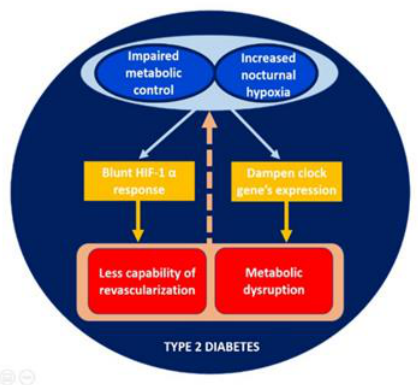
Figure 3. Proposed vicious circle in the relation between nocturnal sleep breathing disorders and disruption of circadian rhythmicity in patients with type 2 diabetes.